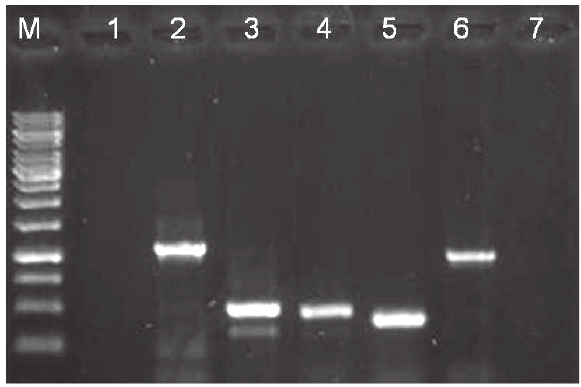
Figure 1. Gel photograph showing amplified product